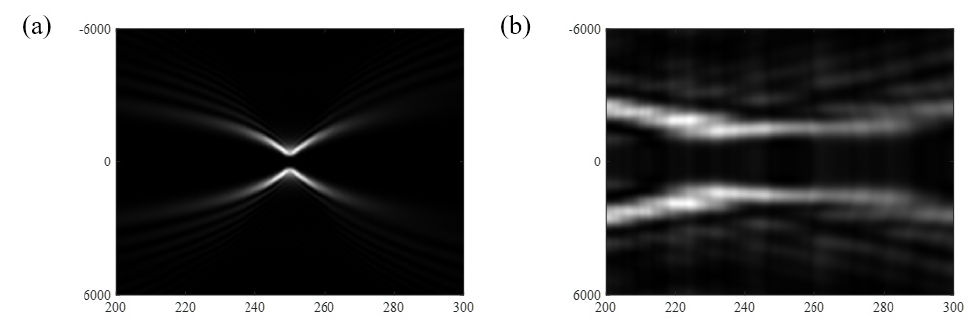
Figure 6. The sampling cross–section patterns along the propagation from z = 200 mm to z = 300 mm for ( a ) the SZP and ( b ) the CSZPG .